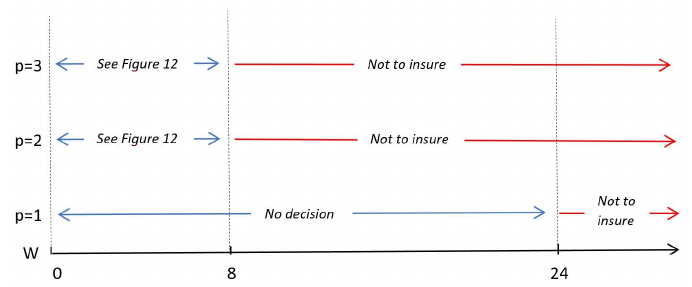
Figure 11. Sign of DU ( W ) for W .